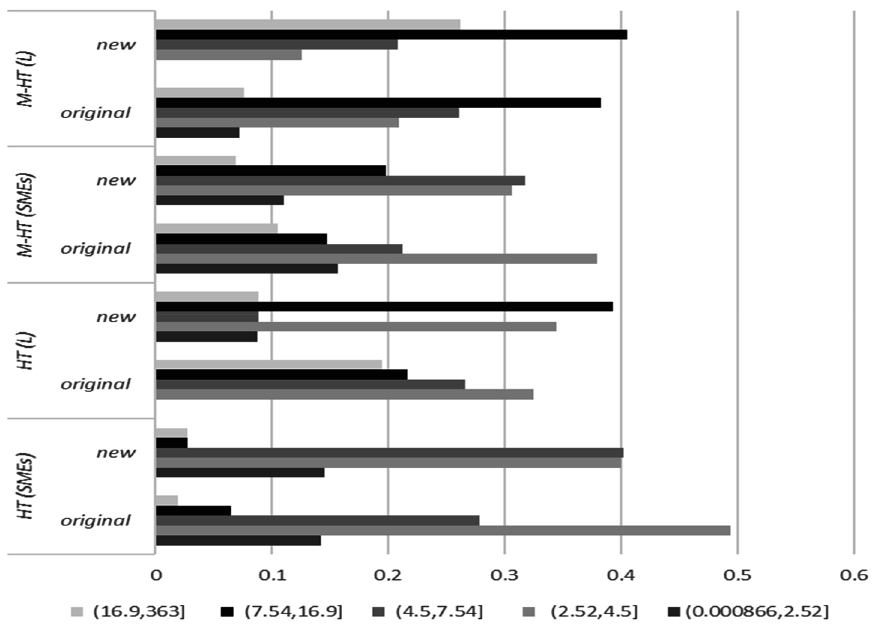
Figure 2. Probability and its change of the output for HT and M-HT enterprises of different size categories (SMEs and L -large) (source: authors’ calculation)